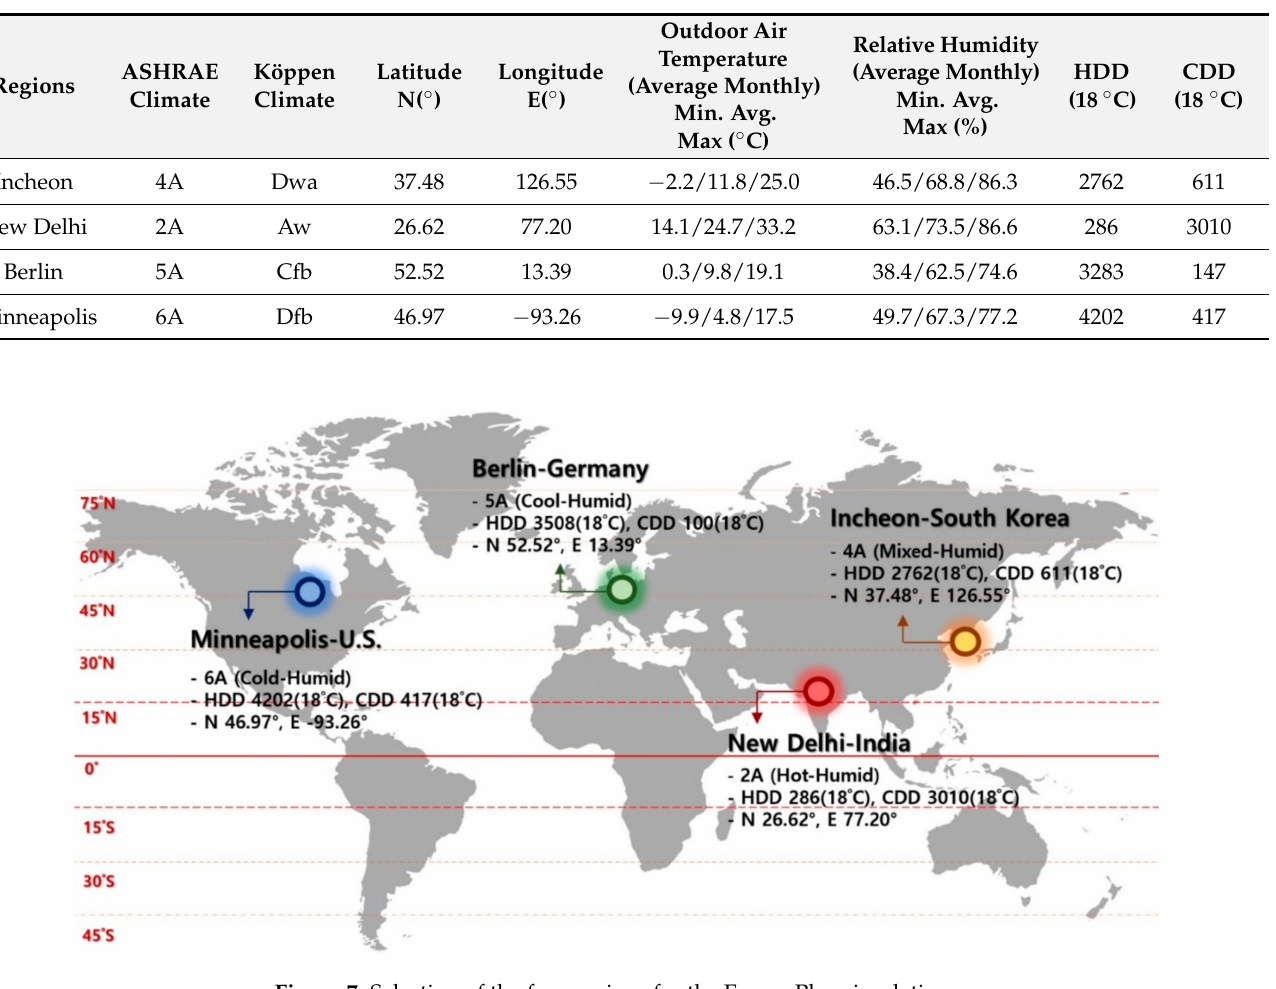
Table 5. Detailed climate characteristics of the four regions.